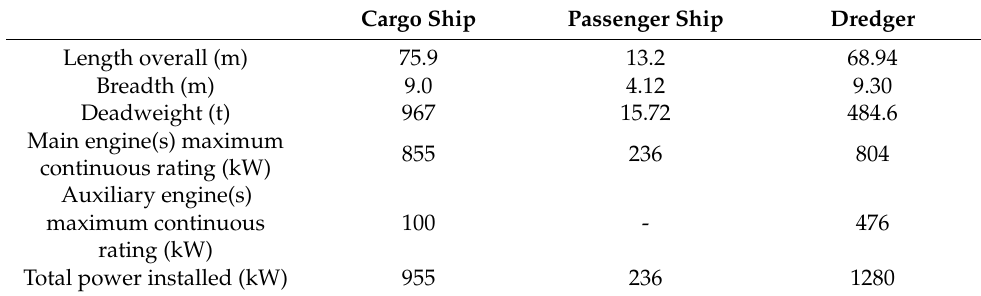
Table 2. Particulars of the selected